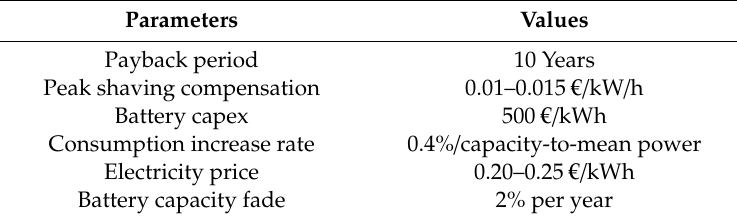
Table 2. Peak Shaving—Parameters for Economic